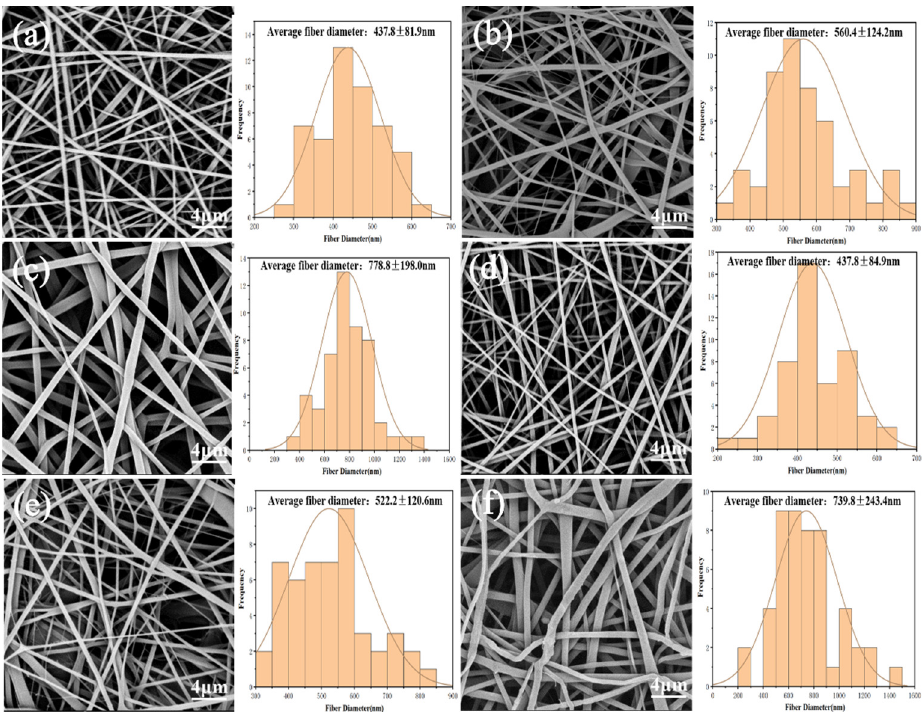
Figure 1. SEM images and diameter distribution: ( a ) SF/PLGA, ( b ) SF/PLGA3, ( c ) SF/PLGA5, ( d ) SF/PLGA/20ICG, ( e ) SF/PLGA3/20ICG and ( f ) SF/PLGA5/20ICG.